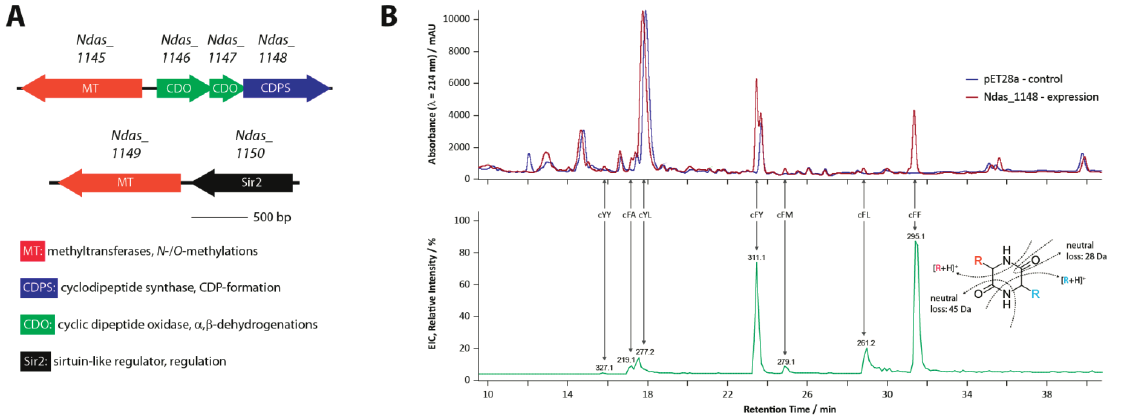
Figure 7. ( A ) Biosynthetic gene cluster of the nocazine family; ( B ) Liquid chromatography-mass spectrometry (LCMS) chromatogram showing the products of the CDPS Ndas_1148; and ( C ) Overview of the nocazine biosynthetic pathway [29]. Investigated CDP-modifications are shown in red and